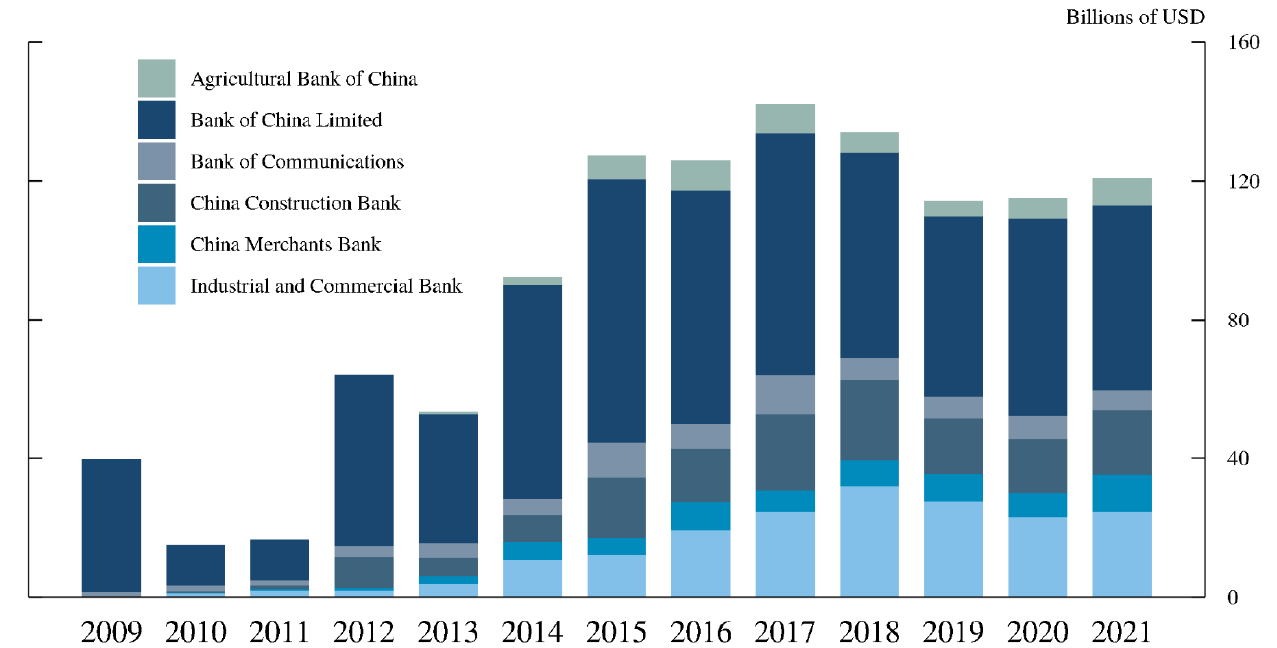
Figure 3. U.S. branch assets of Chinese banks. Source: U.S. Federal Reserve Board. Data reported for Q1 of each year.